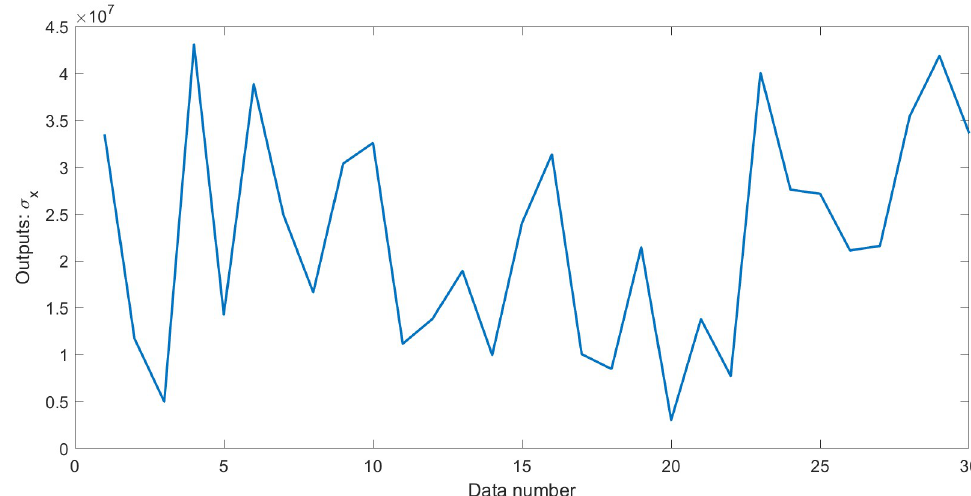
Fig 9. Outputs σ x with errors in dataset 3.